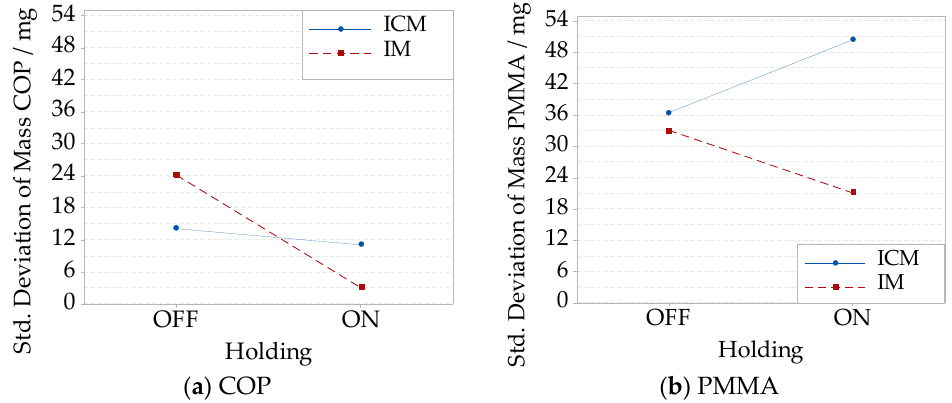
Figure 14. Interactions plots showing the part mass’ standard deviation for different compression and holding combinations: IM without the holding pressure, IM with the holding pressure, ICM without the holding pressure, and ICM with the holding pressure: ( a ) COP material; ( b ) PMMA material. Increasing the holding pressure with a short compression gap resulted in a mass increment from (14.067 ± 0.008) g to (14.282 ± 0.004) g (i.e., +1.5% increase), and from (14.088 ± 0.001) g to (14.298 ±